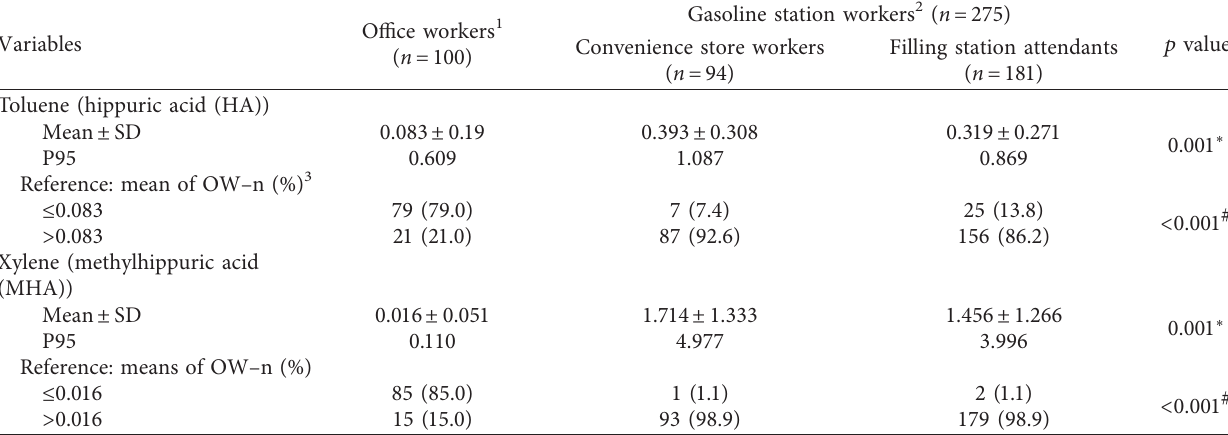
Table 2: Mean, P95 values, and distribution of workers by the levels of hippuric acid and methylhippuric acid in gasoline station workers (occupationally exposed to VOCs) and office workers (comparison group) from Rio de Janeiro (Brazil), 2015–2017.